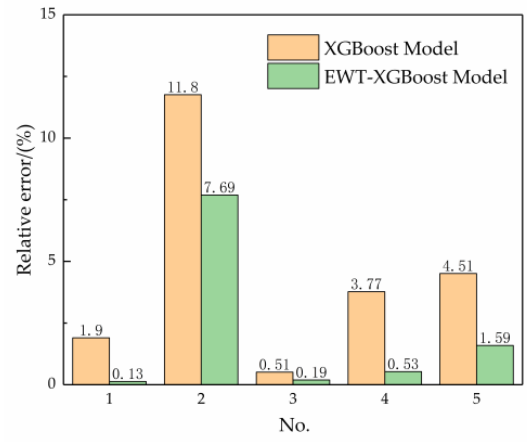
Figure 6. Relative results histogram of the prediction results.